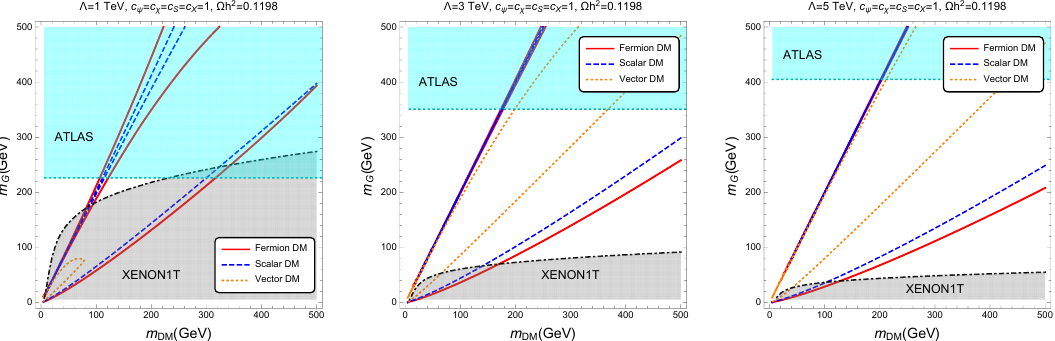
Figure 7 . Parameter space of fermion and scalar dark matter in m DM vs m G . The gray and cyan regions are excluded by XENON1T and ATLAS dijet searches, respectively. We took (cid:3) = 1 ; 3 ; 5 TeV on left, middle and right, respectively. The other parameters are the same as in (cid:12)gure